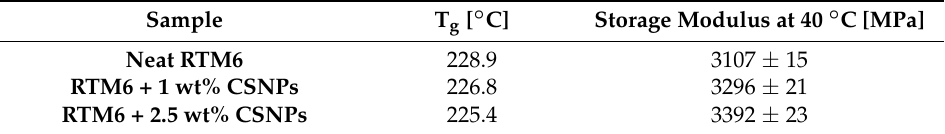
Table 1. Glass transition temperature (T g ) and storage modulus of the CSNPs/RTM6 nanocomposites obtained by DMA.